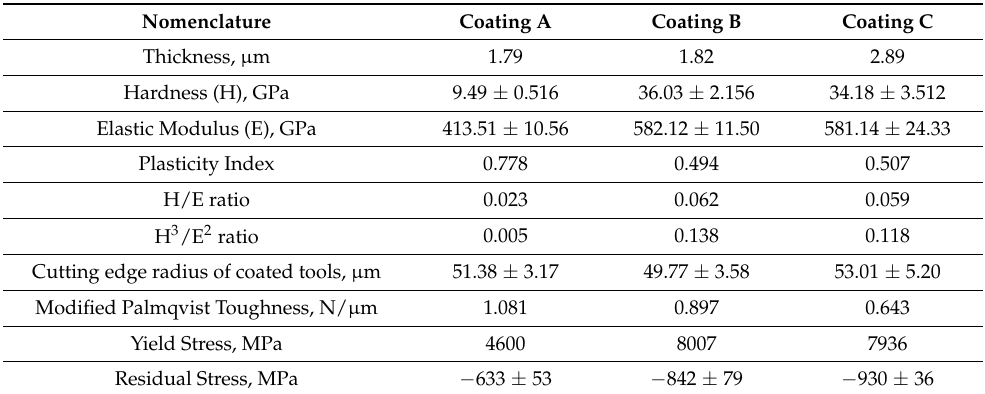
Table 1. Micro-mechanical properties of the three monolayer TiB 2